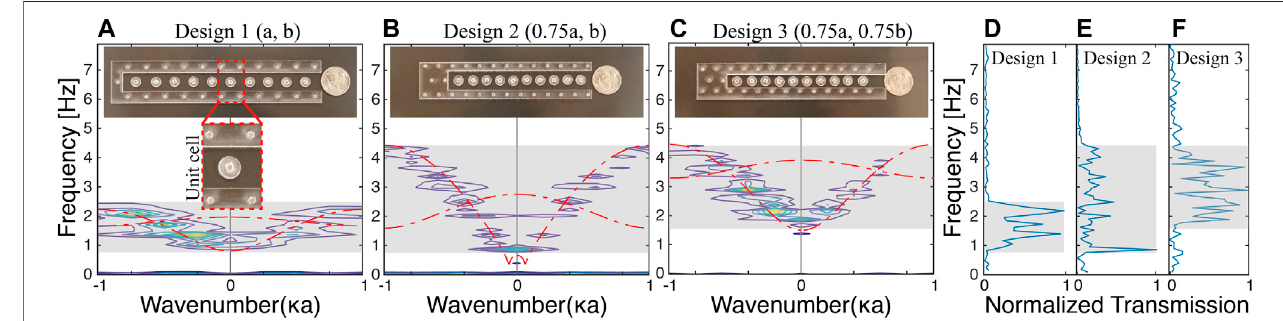
FIGURE 3 | Characterization of individual channels. The experimentally measured dispersion curves plotted as contours with the numerical dispersion curves superimposed as dashed red lines for (A) design 1 with a (cid:2) 15 . 4 mm , b (cid:2) 24 . 5 mm (B) design 2, with a (cid:2) 11 . 5 mm , b (cid:2) 24 . 5 mm , and C) design 3, with a (cid:2) 11 . 5 mm , b (cid:2) 18 . 4 mm .Theinsetsshowtheexperimental samplesused.Themeasurednormalizedtransmissionatthecenteroflatticefor D) design1, E) design2,and F)